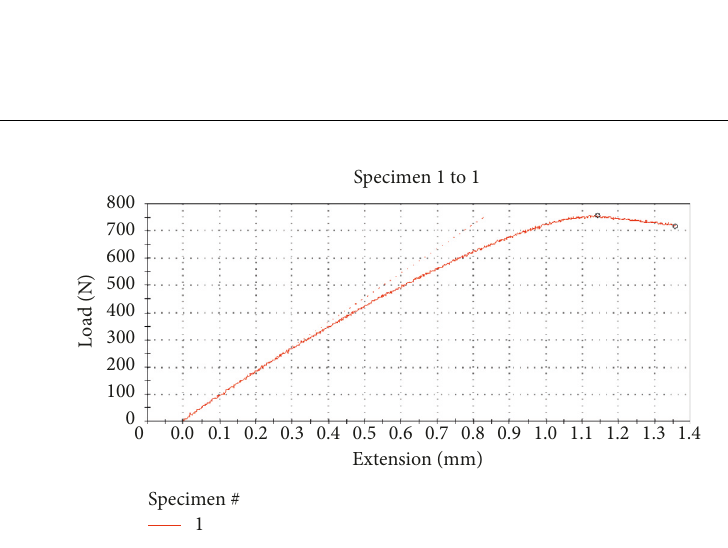
Figure 6: Tensile load-extension curve for specimen